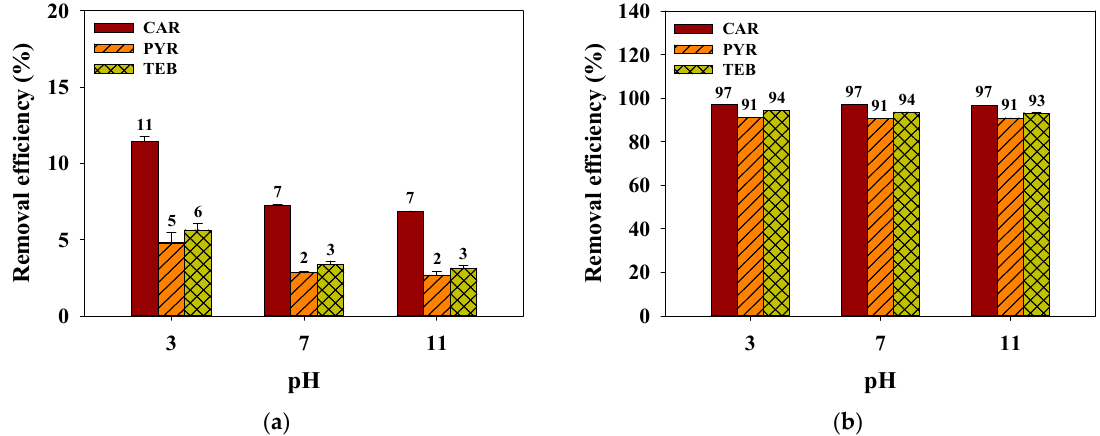
Figure 7. The effects of the pH on the adsorption of fungicides by ( a ) the PSB and ( b ) PSB OX-A (agitation speed = 150 rpm; contact time = 24 h; absorbent dosage = 50 mg L − 1 ; initial concentration of each fungicide = 10 μ M; temperature = 25 °C).